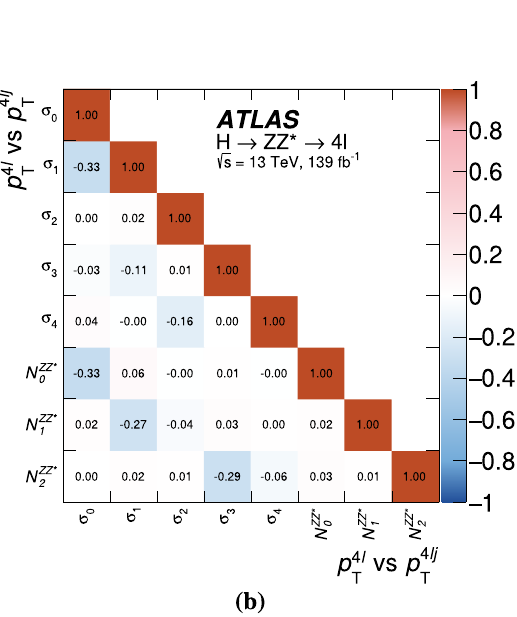
matrix between the measured cross sections and the Z Z ∗ background normalisation factors. The bin boundaries are defined in Fig. 14